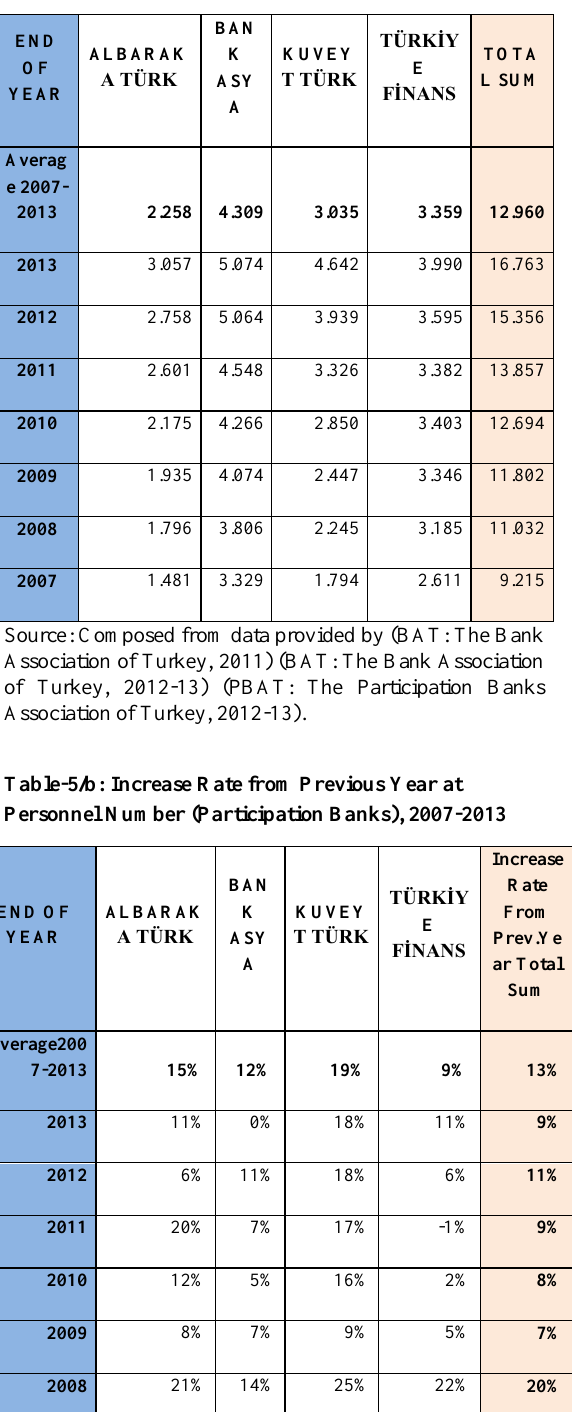
Table- 5/a: Growth of Personnel Number (Participation Banks), 2007-2013